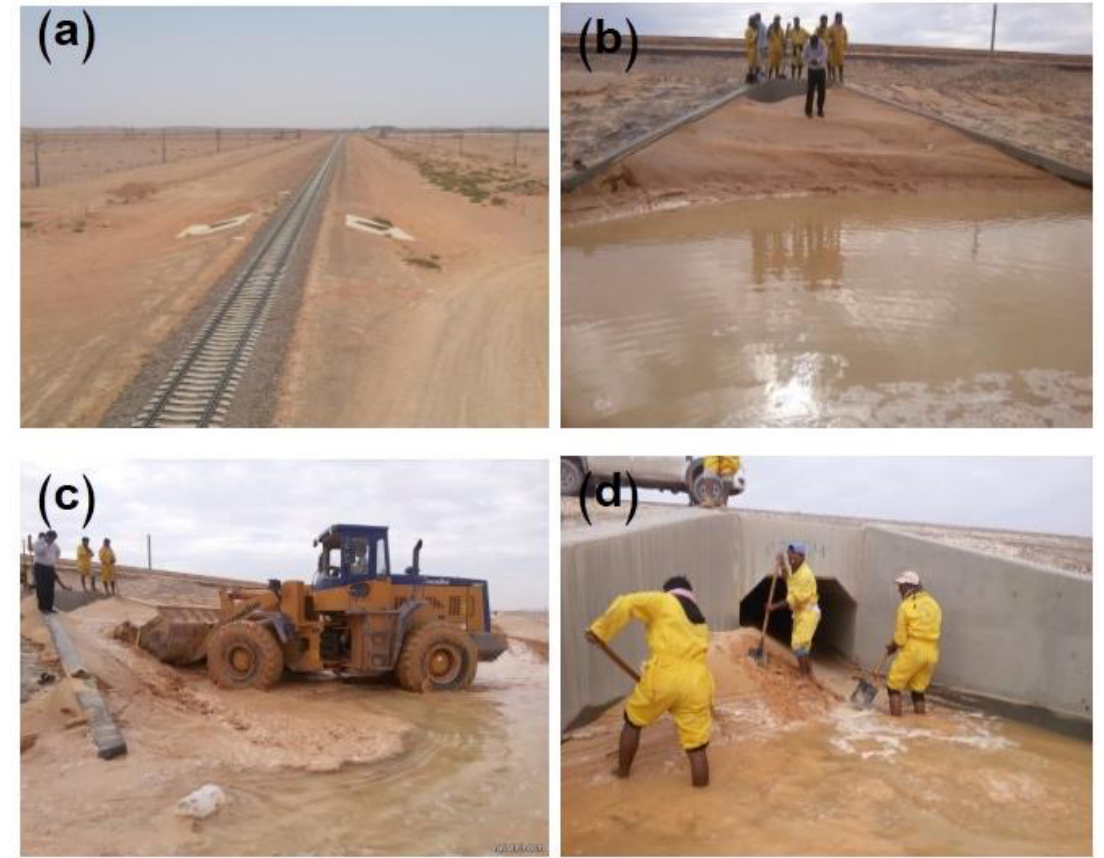
Figure 16. ( a ) Part of the Al-Shamal train pathway; ( b ) the existing structures under the train pathway which are blocked by Wadi Bayer floodwater sediments in front of the train pathway; and ( c , d ) the process of removing sediment from under the Al-Shamal train pathway.